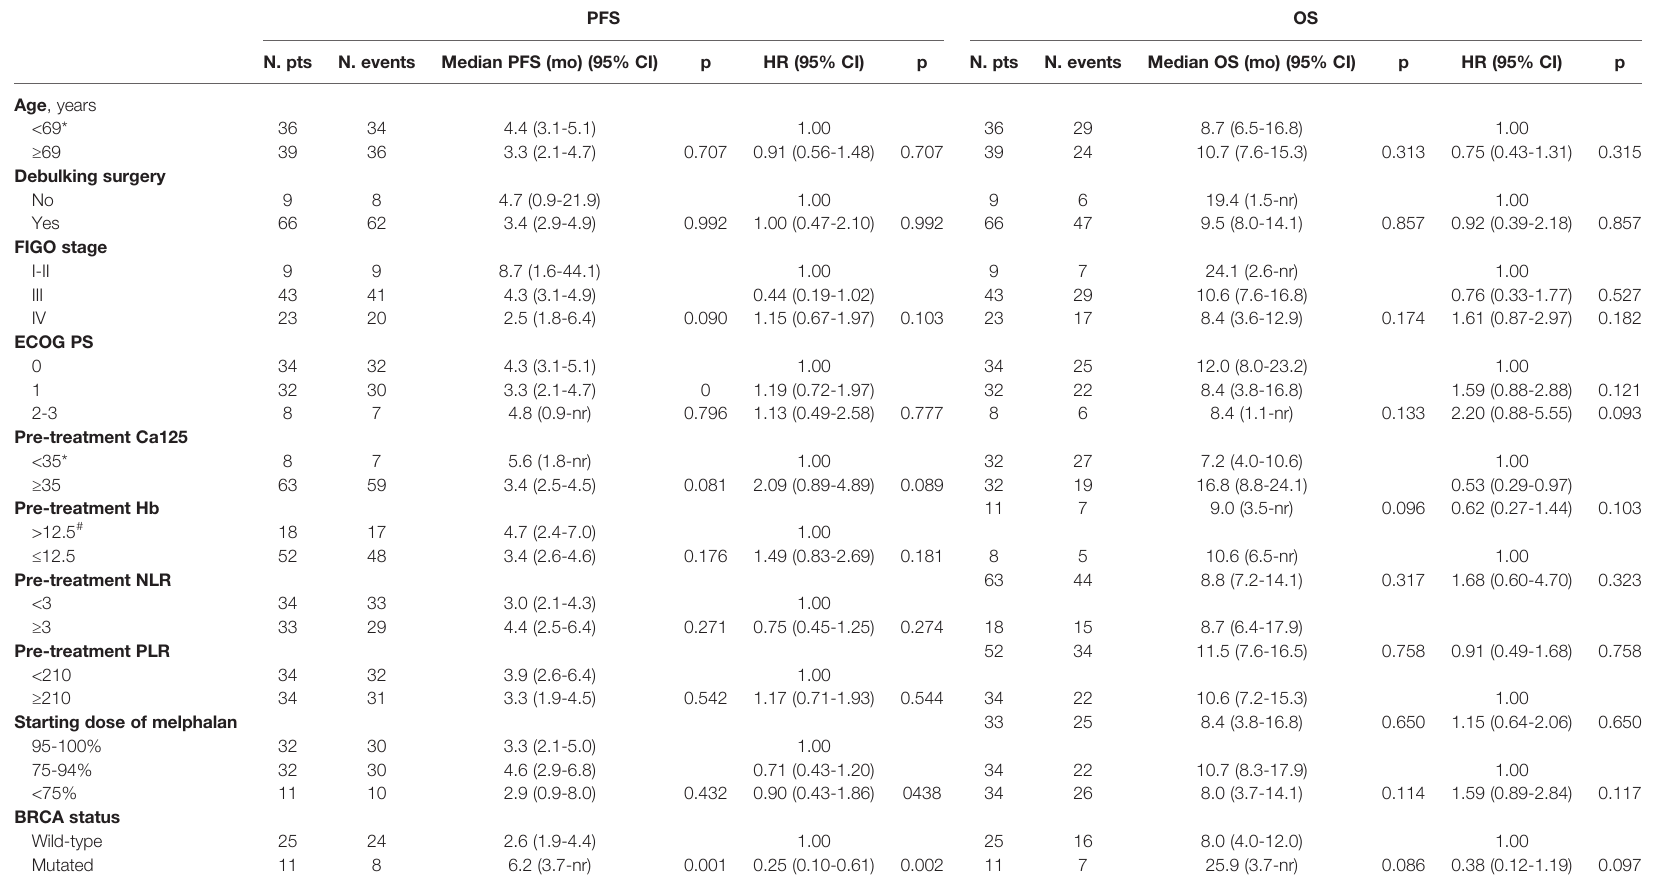
TABLE 2 | Univariate analysis of progression-free survival and overall survival.